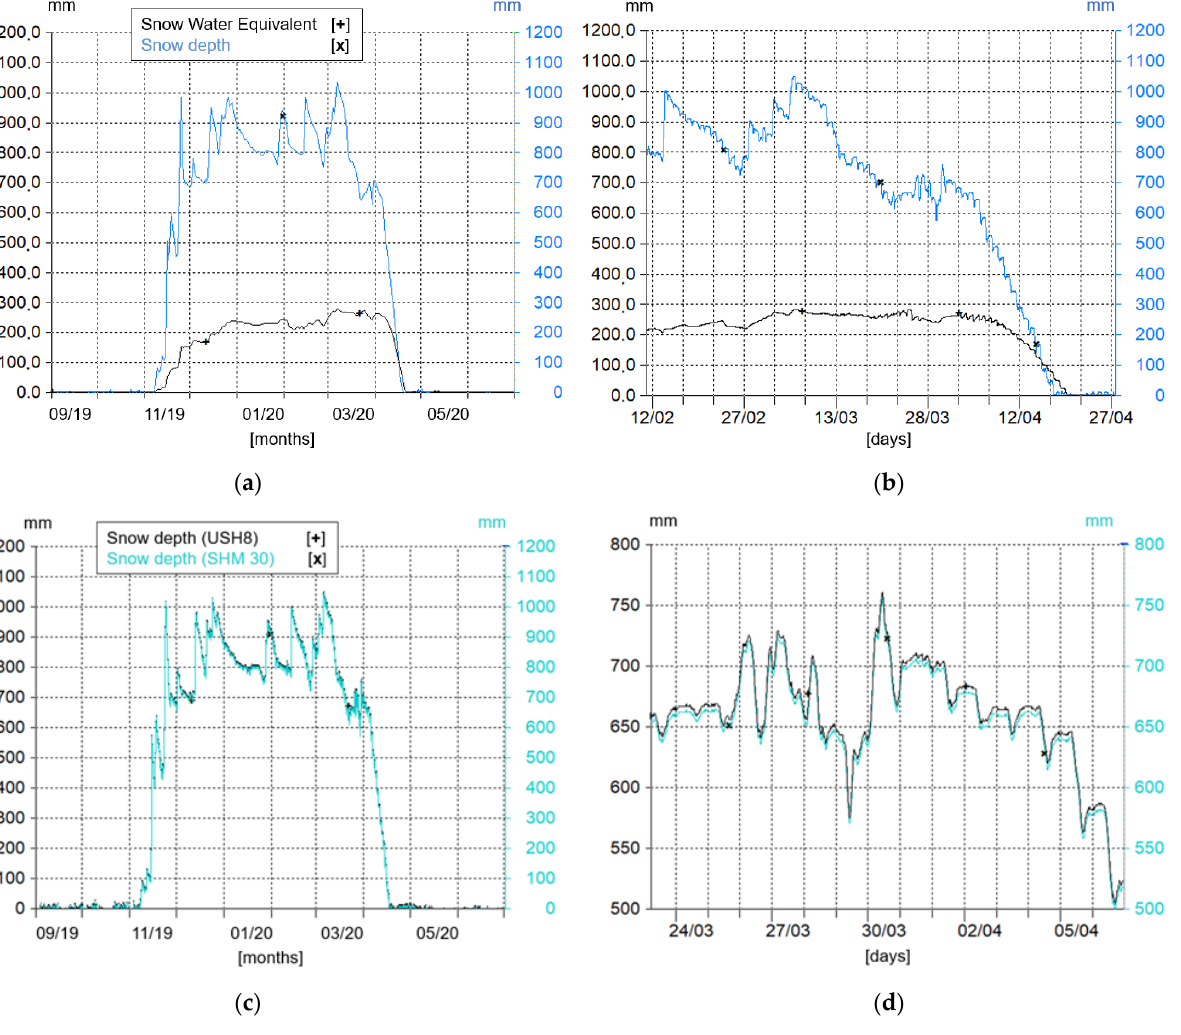
Figure 5. Graphs representing the parameters recorded from snowpack station sensors (Hydras 3 software layout): ( a , c ) Are day mean values; ( b , d ) Are the real values registered with the time interval of 10 min.